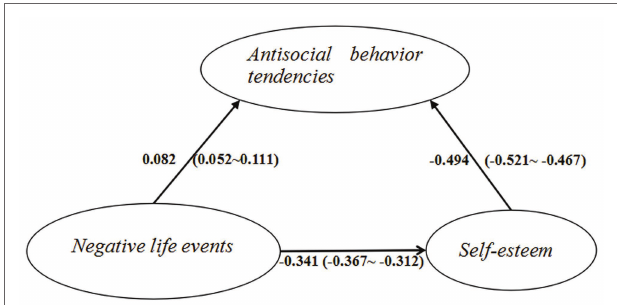
Table 3 . A stronger indirect effect of negative life events was seen with low family support (conditional indirect effect = 0.227,